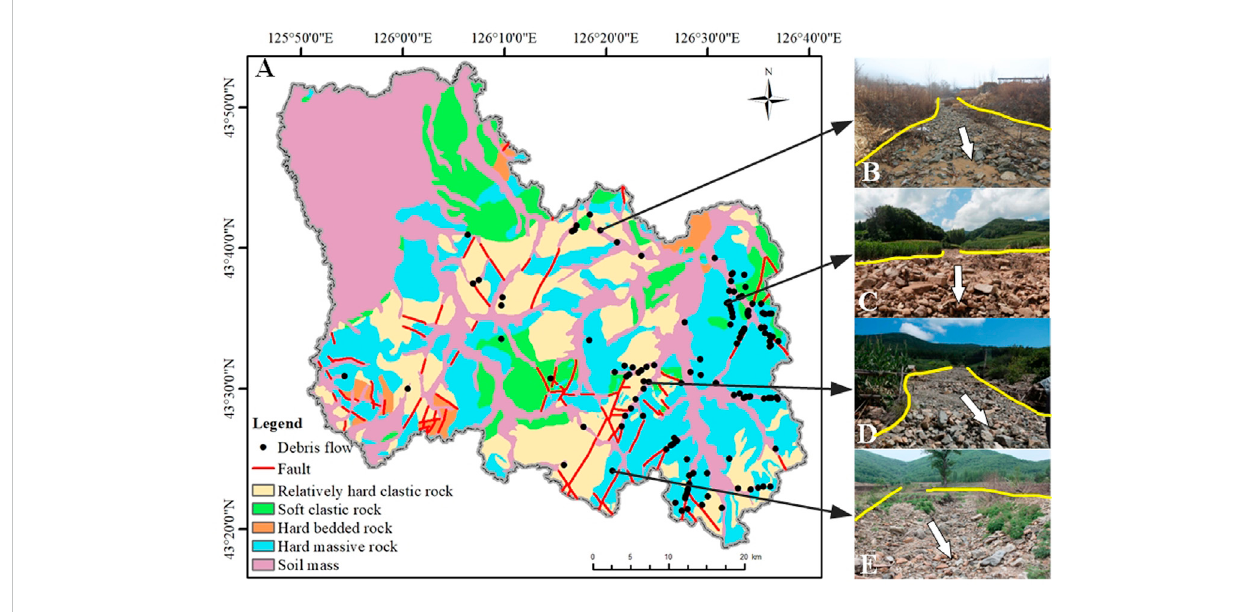
FIGURE 2 Geological map and debris fl ow fi eld photos of the study area: (A) geological map; (B – E) debris fl ow fi eld